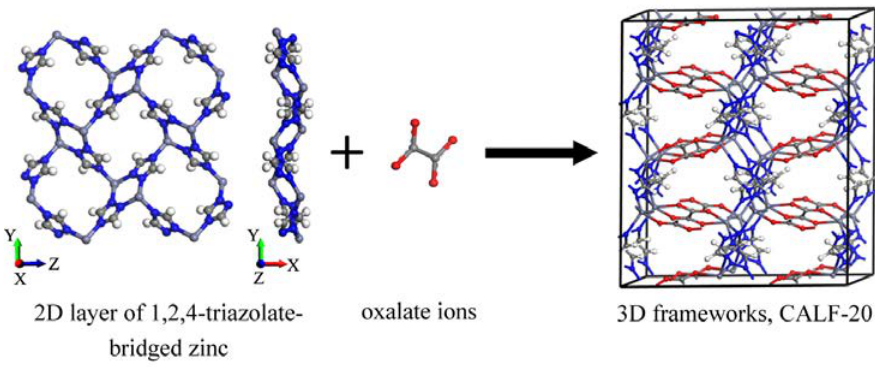
Figure 1. Schematic diagram for the synthesis of CALF-20.